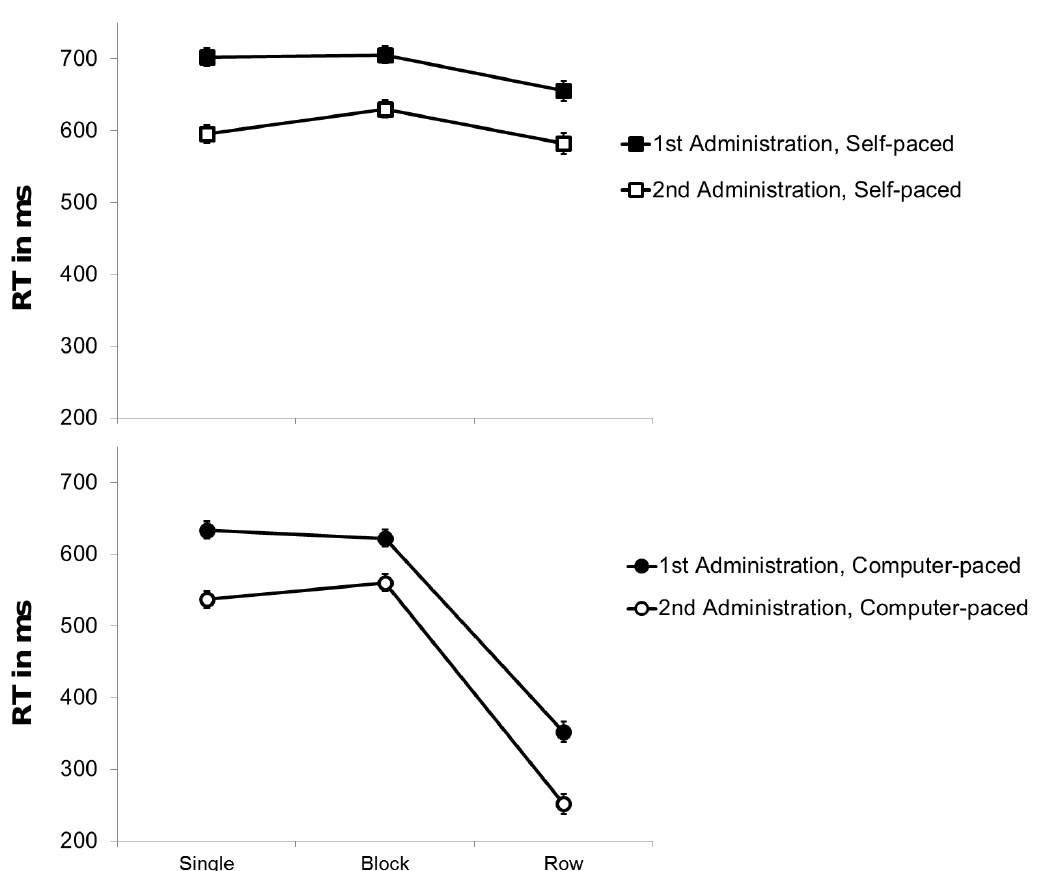
Figure 2. Mean RT (in ms) of the modified d2 as a function of stimulus arrangement (single versus blocks versus rows of stimuli) and pace (self-paced versus force-paced) for the first and second administration. Bars represent standard errors.